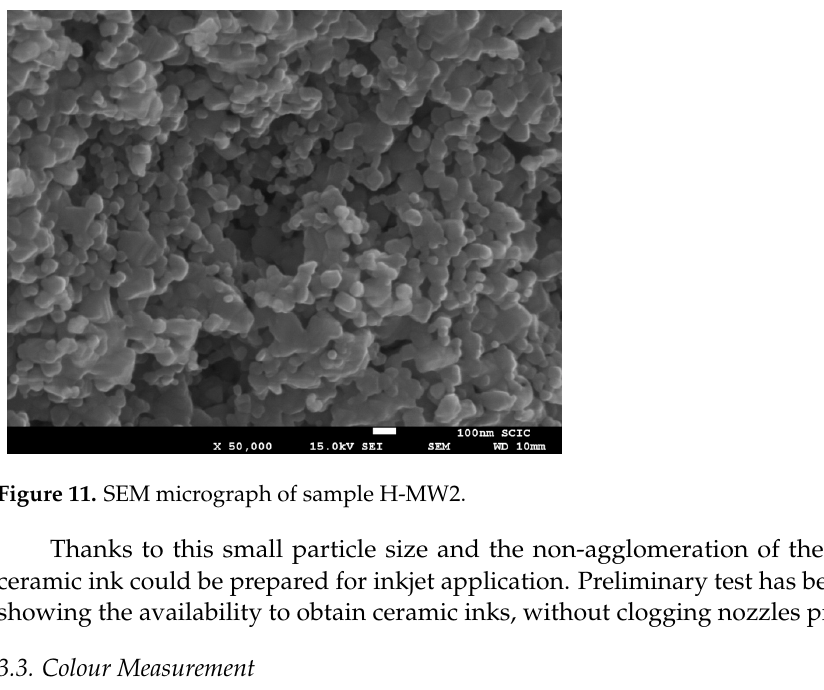
Figure 10. SEM micrograph of sample H-M5.